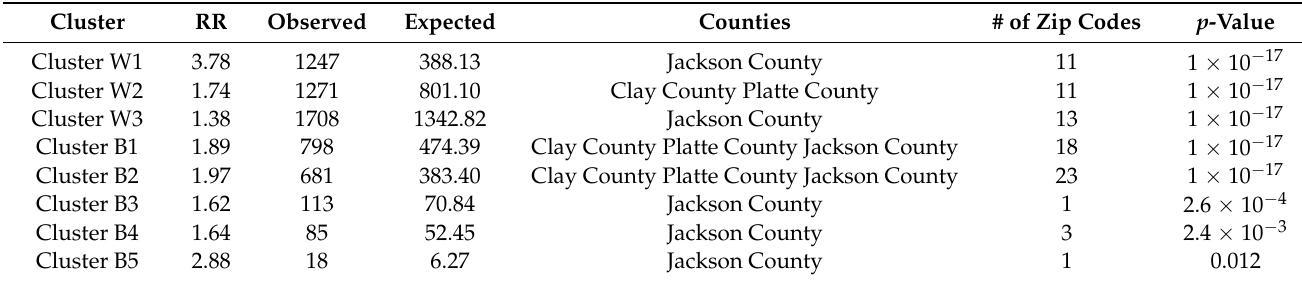
Figure 5b and Table 5 provide details of the spatial COVID-19 clusters with respect to White and African American populations in Kansas City at the zip code level from March to November 2020. There were five spatial clusters belonging to the African American and three spatial clusters belonging to the White population. Note that the RR for the primary cluster (W1) of the White population was almost twice that of the RR for the primary cluster (B1) of the African American population. However, cluster B5 had a greater RR than that of primary cluster B1. Figure 5b shows that the clusters of the African American and White populations were mainly shared in Clay County. Note that the secondary cluster B2 of the African American population covered almost the entire county. Table 5. Spatial clusters of COVID-19 with respect to race and ethnicity: White population (W) and African American population (B). Cluster RR Observed Expected Counties